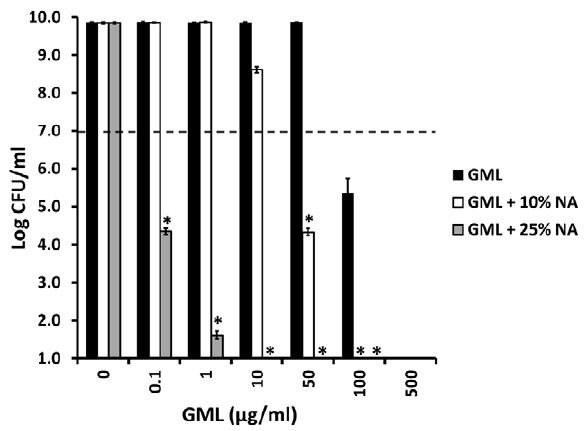
Figure 14. Effect of a nonaqueous (NA) gel on GML antibac- terial activity against Staphylococcusaureus MN8. Non-aqueous gel was diluted to 25% and 10% with Todd Hewitt broth. GML and Staphylococcus aureus MN8 were added, and cultures were incubated for 24 hours. CFU/ml were determined by plate counts. Dashed line indicates the inoculum size. * indicates mean differs significantly from the GML alone control at p , 0.001.